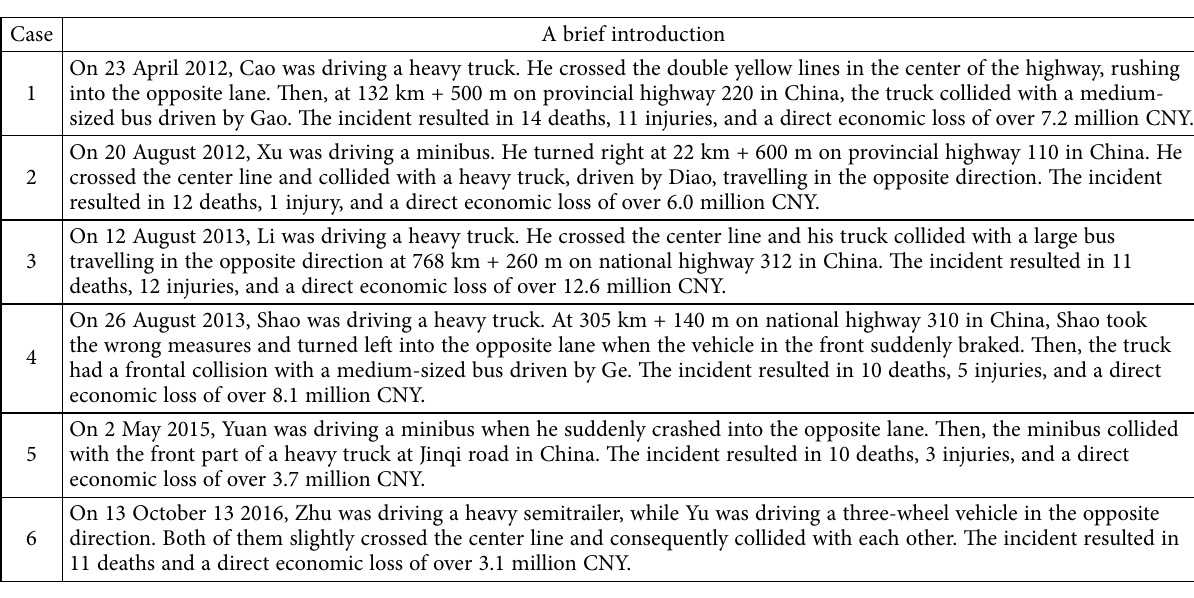
Table 5. A brief introduction to six TC cases in China